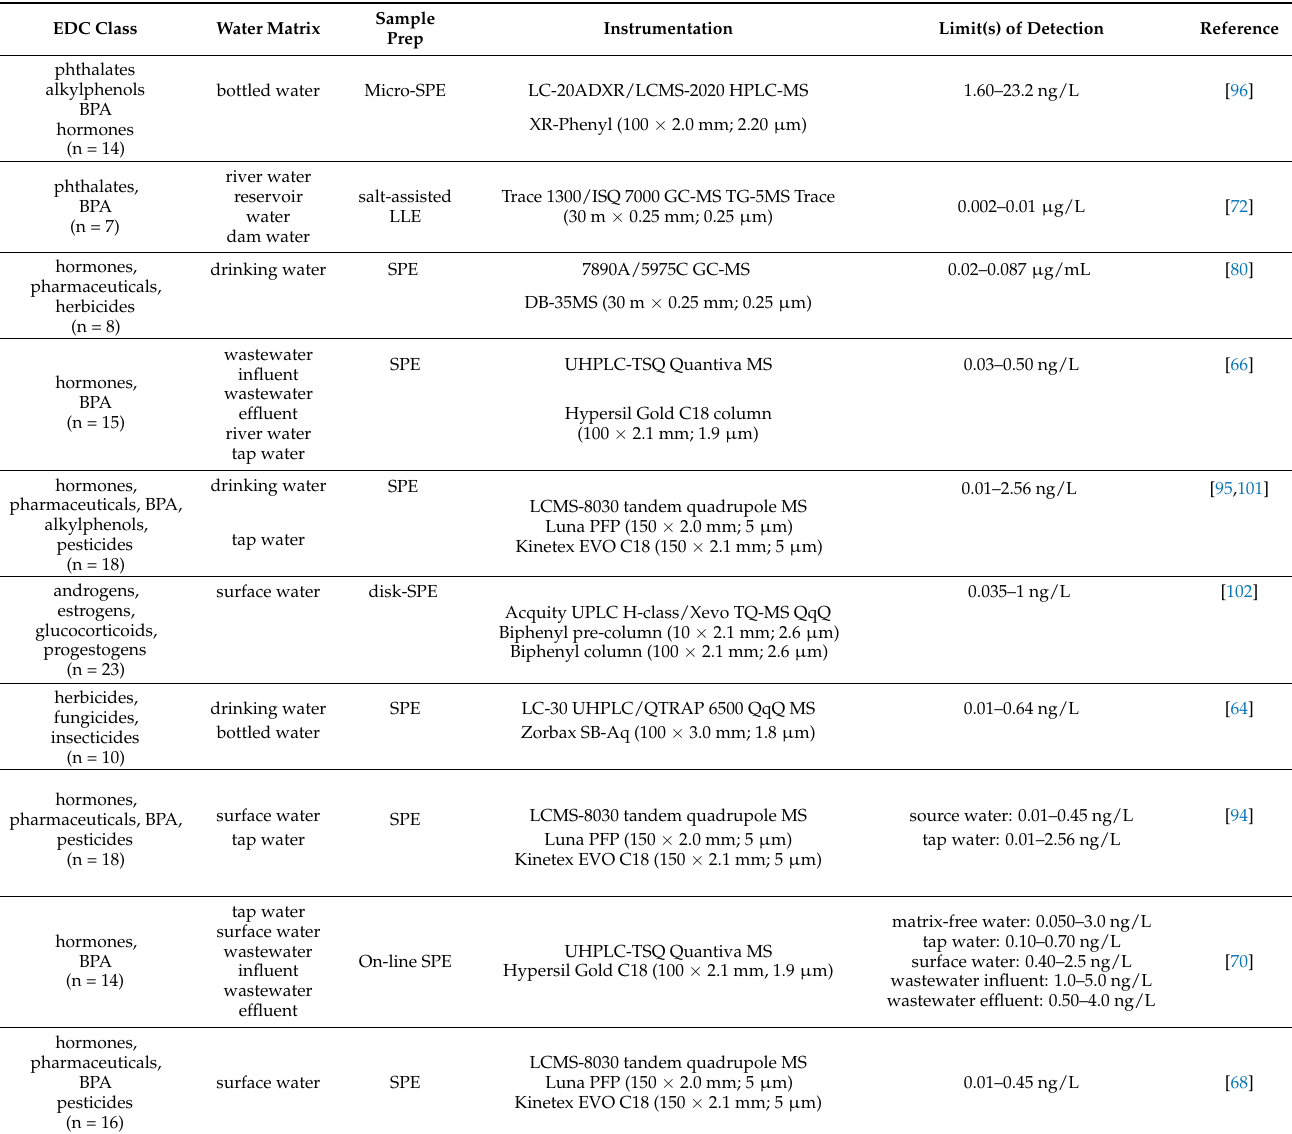
Table 1. Recent analytical methods for the determination of targeted multiclass endocrine disrupting compounds in different water matrices using single or QqQ MS